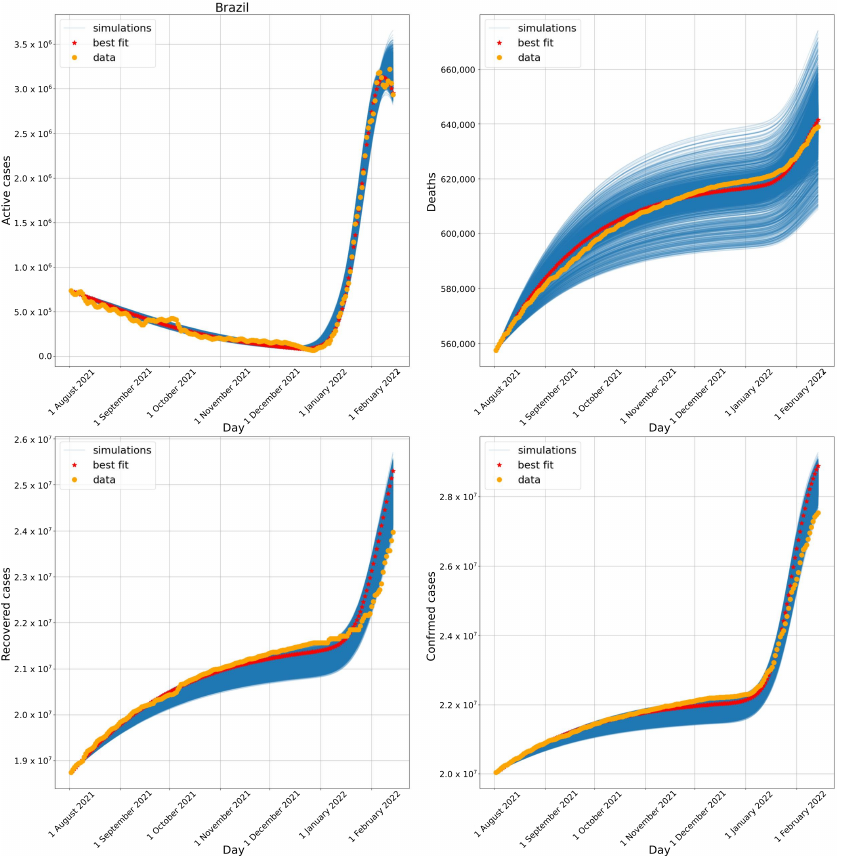
Figure 4. Evolution of the number of active cases ( upper left ), deaths ( upper right ), recovered cases ( lower left ), and confirmed cases ( lower right ) in Brazil. All simulations with errors below 10% are